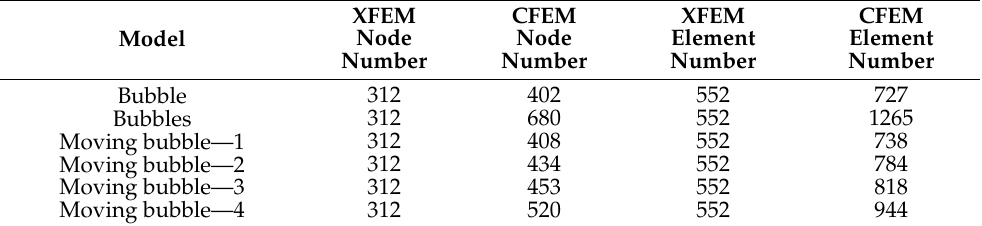
Table 4. Numerical cost of CFEM and XFEM.